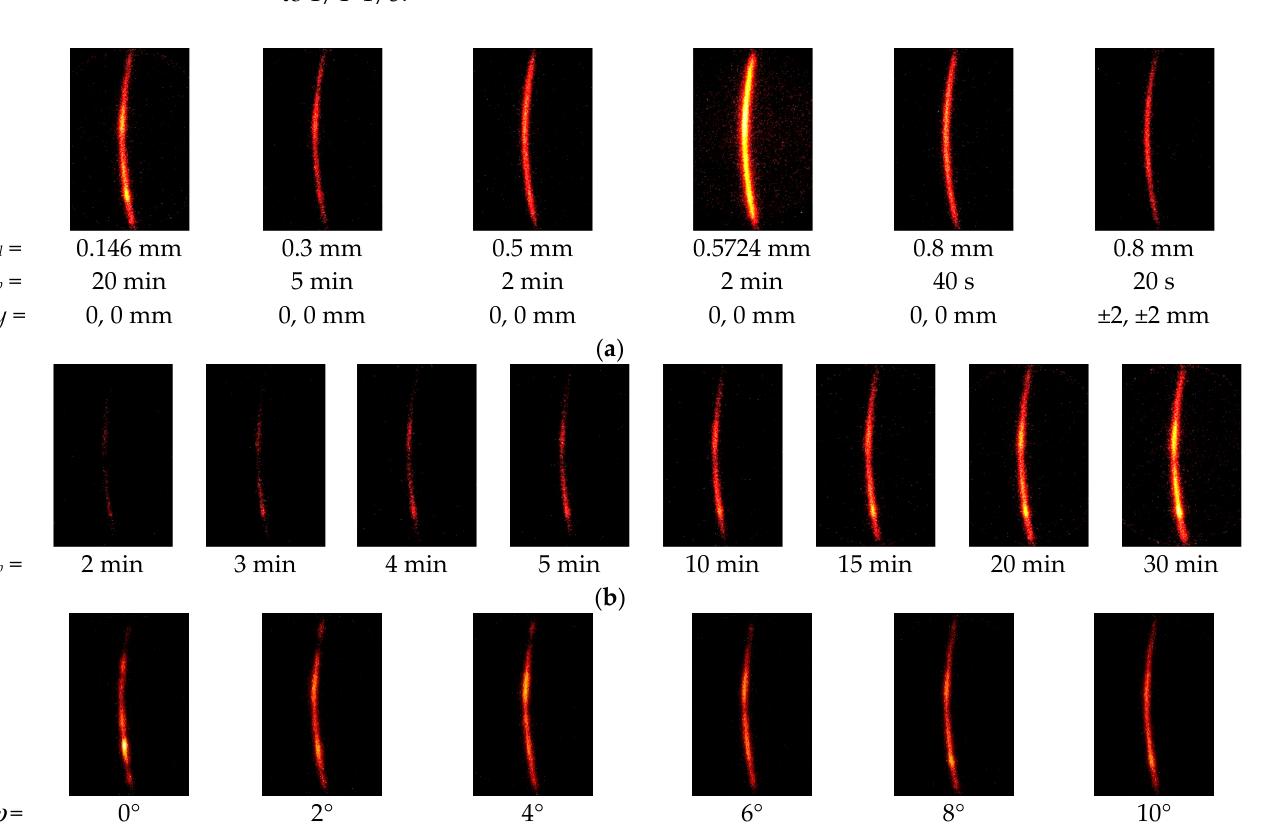
Figure 11. Relationship between the counts at ψ = 0° and φ = 0° detected by 2D-PSPC and the stand- ard deviation of the residual stress of stainless steel treated by cavitation peening (specimen A) changing with exposure time t exp , collimator diameter d col and ω -oscillation angle ∆ ω . In order to confirm that the 2D method can evaluate the residual stress of the austen- itic stainless steel by using the 0.146 mm-diameter collimator, Figure 12a reveals the re- sidual stress ( σ Rx , σ Ry ) of specimen A, B and C as a function of the diameter of the collimator d col , and Figure 12b shows the standard deviation of the residual stress. The data for spec- imen A in Figure 6 were used as the σ Ry in Figure 12. For all three specimens, A, B and C, as both σ Rx and σ Ry at d col = 0.146 mm were nearly equal to the values at d col = 0.8 mm, the residual stresses of d col = 0.146 mm for specimens A, B and C were able to be evaluated.